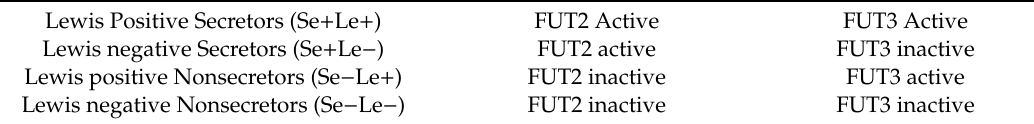
Table 2. Groups of mothers with di ff erent fucosylated HMO profiles.